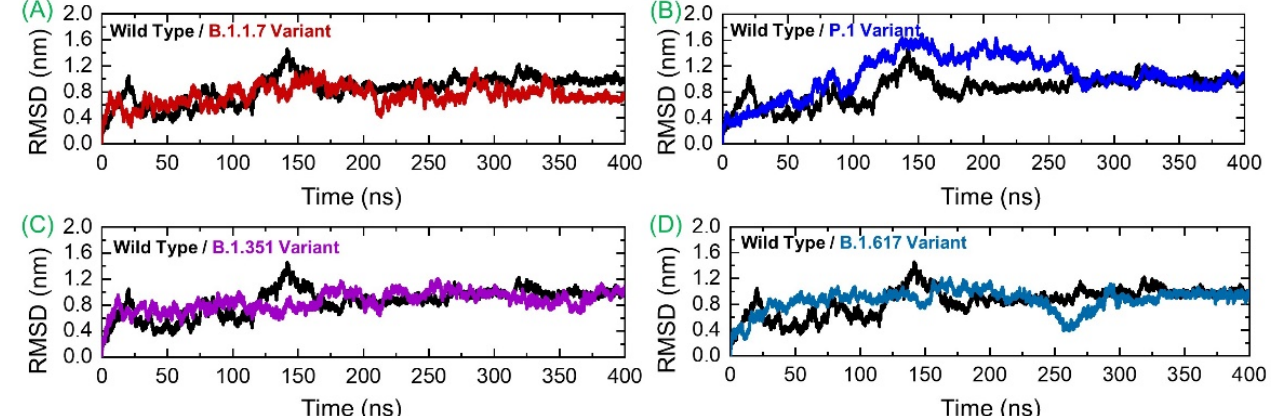
Figure 5. Structural and dynamic stability of GRP78 and spike RBD of the wild-type and variants calculated as RMSD. ( A ) shows the RMSD of wild-typeRBD-GRP78 complex; ( B ) shows the RMSD of B.1.1.7-RBD-GRP78 complex; ( C ) shows the RMSD of P.1-RBD-GRP78 complex; ( D ) shows the RMSD of B.1.351-RBD-GRP78 complex.